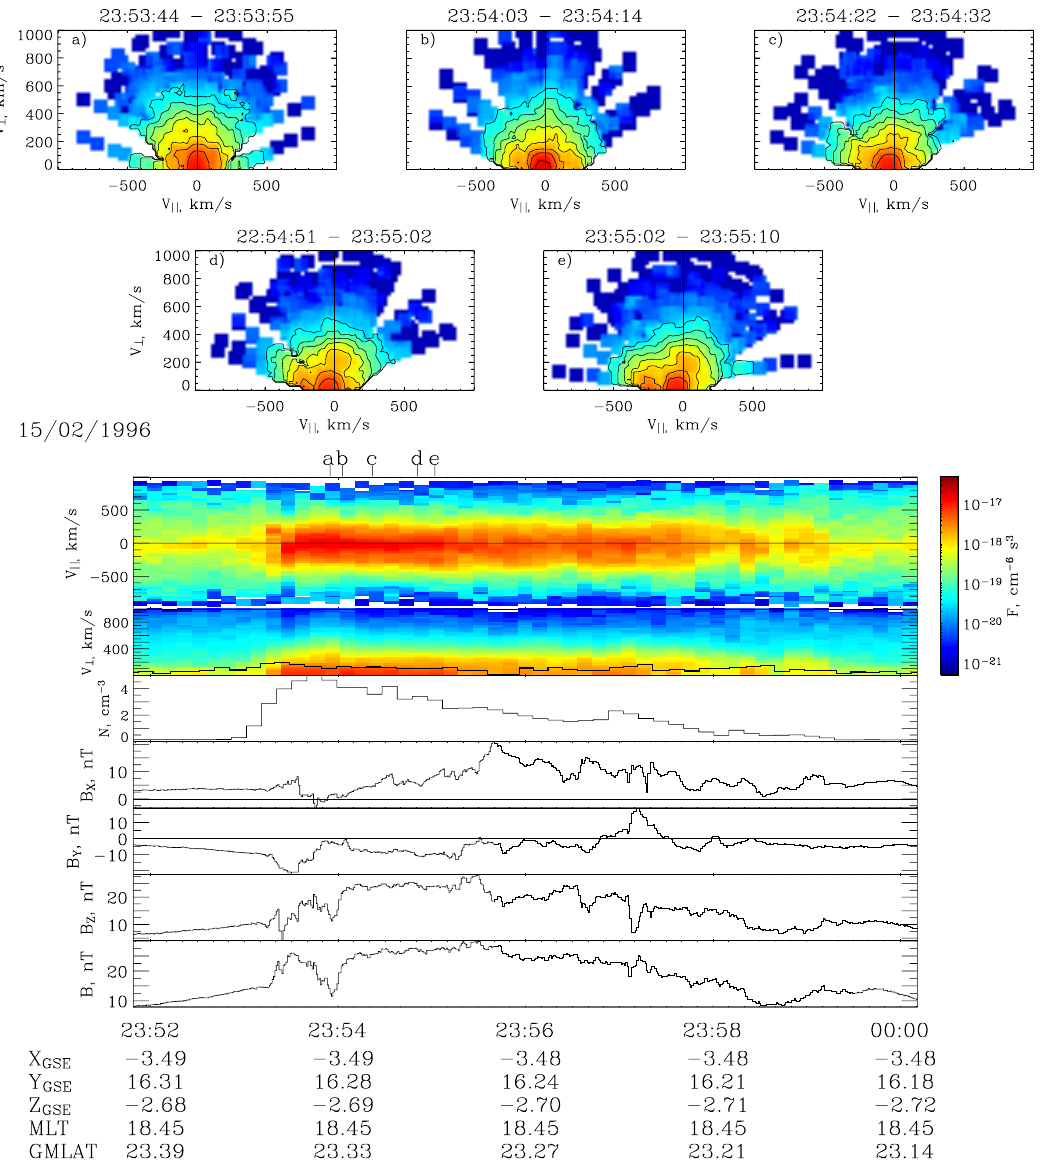
Fig. 8. Ion velocity distributions within transient observed at ∼ 23:35UT on 15 February 1996. Format of the figure is the same as in Fig. 10. Five representative ion velocity distributions (see text for explanation) are shown on the